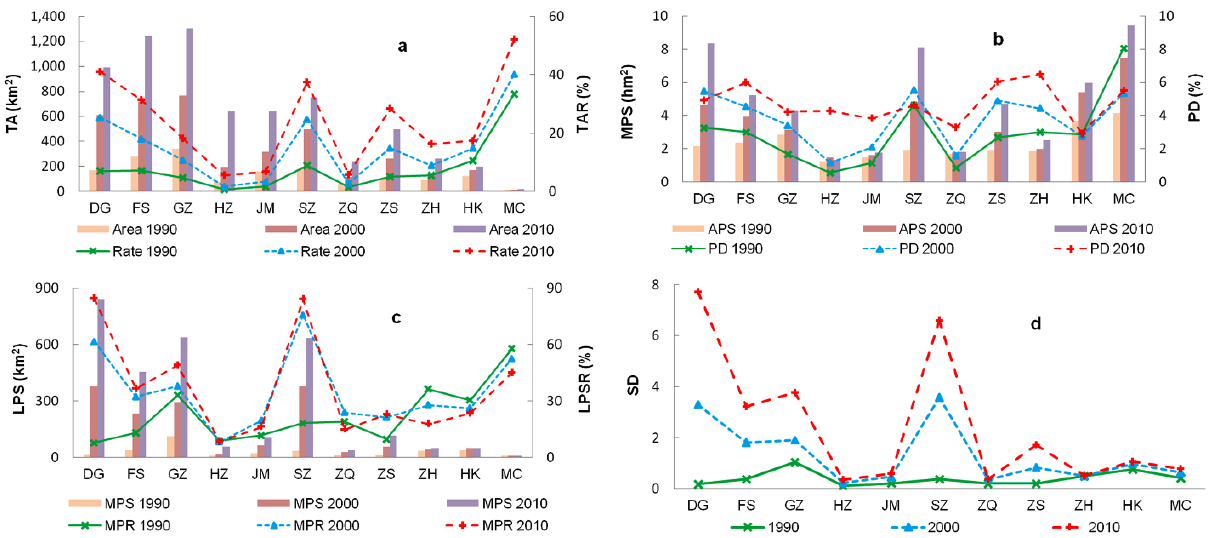
Figure 4. Variation of patch indices for built-up land in municipalities. ( a ) total area and rate; ( b ) average patch size (APS) and patch density (PD); ( c ) maximum patch size (MPS)